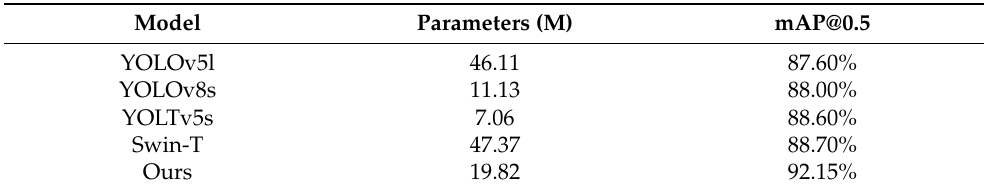
Table 6. Experimental results of comparative